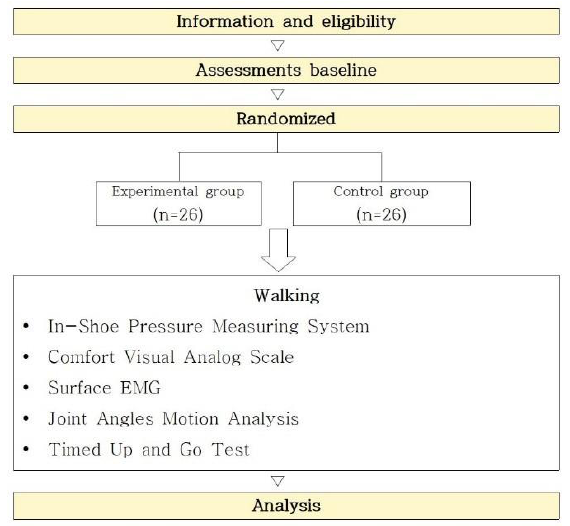
Figure 2. Protocol for a single-blind, randomized, parallel-group study.